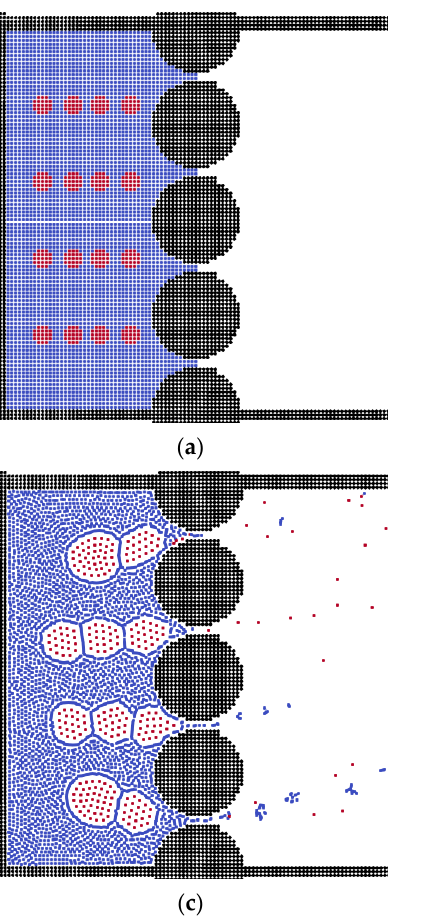
Figure 3. The separation processes in the sphere membrane during different time steps. ( a ) Step = 0, ( b ) Step = 20, ( c ) Step = 100, ( d ) Step =